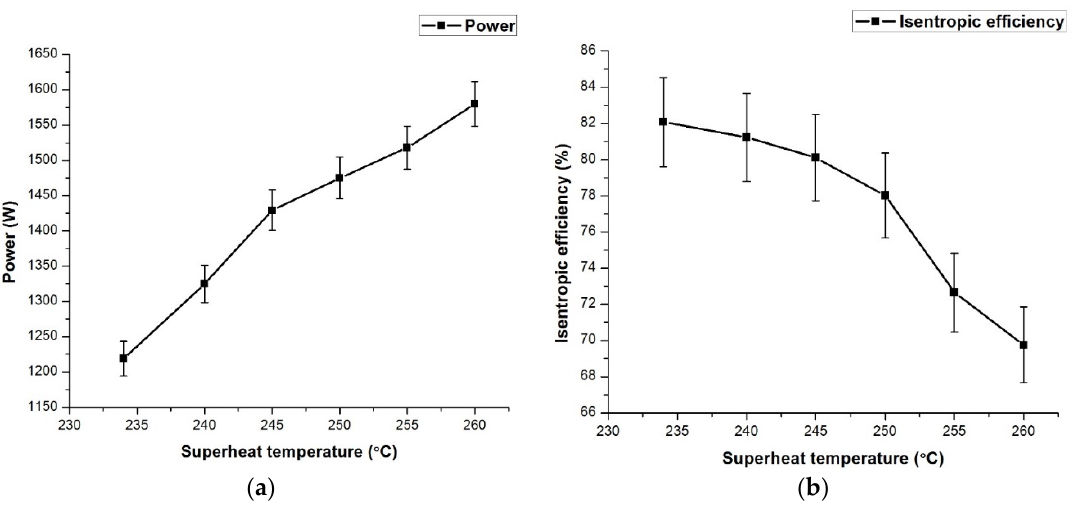
Figure 10. Variation of isentropic efficiency ( a ) and power ( b ) with superheat temperature.